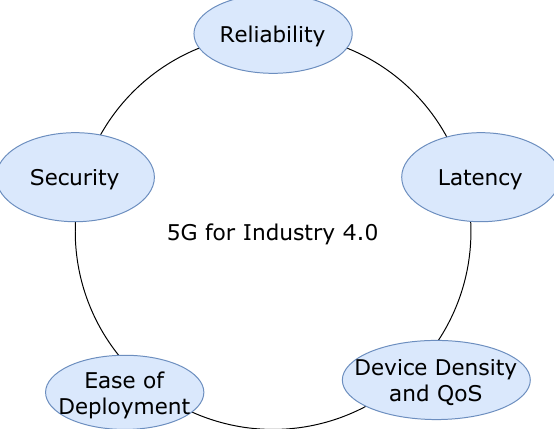
Figure 2. 5G communication opportunity for Industry